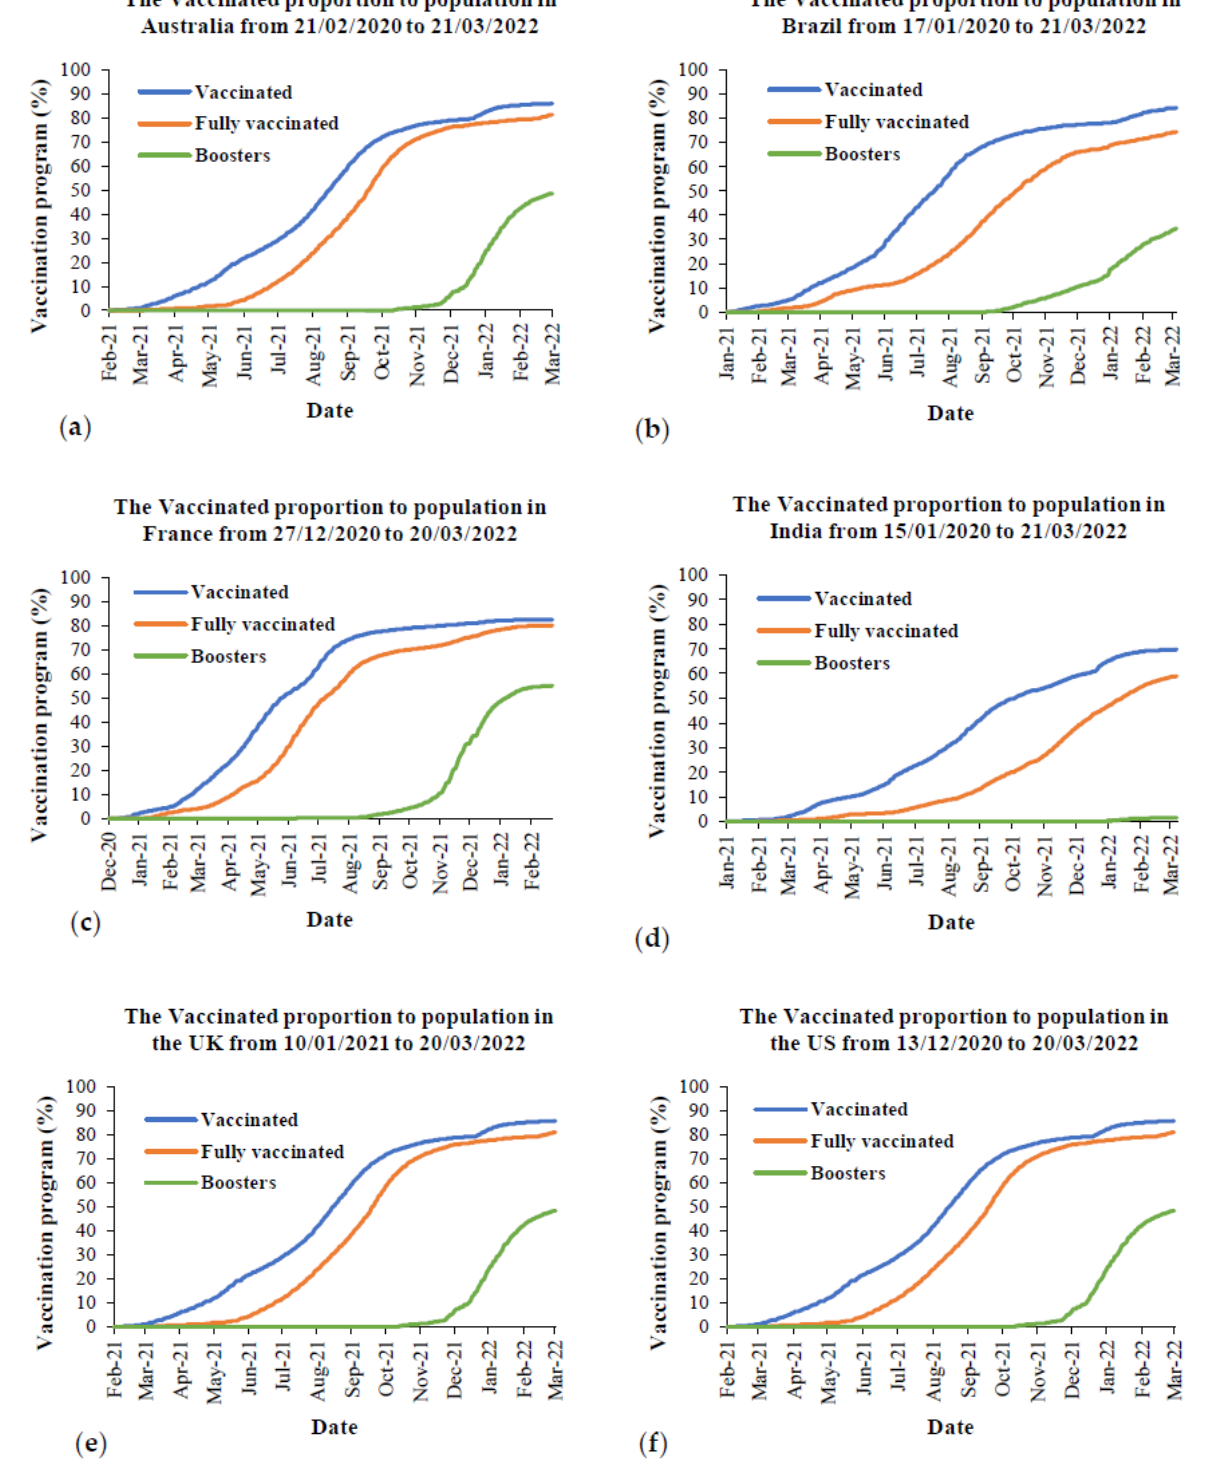
Figure 18. The vaccination programs in Australia and the most affected countries from the begin- ning to March 2022: ( a ) Australia, ( b ) Brazil, ( c ) France, ( d ) India, ( e ) the UK, and ( f ) the US.